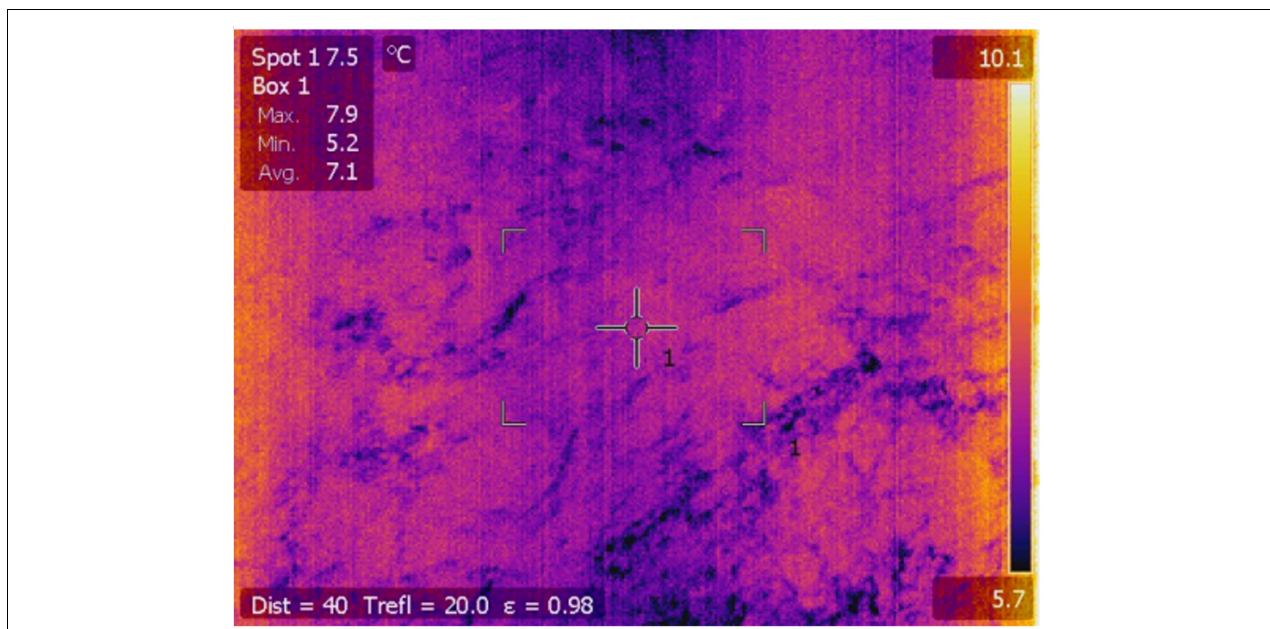
FIGURE 7 | An example of an abnormal TIR image acquired on December 16, 2016 at 03:57 (corresponding to the winter period highlighted with a red rectangular box in Figure 6A ).